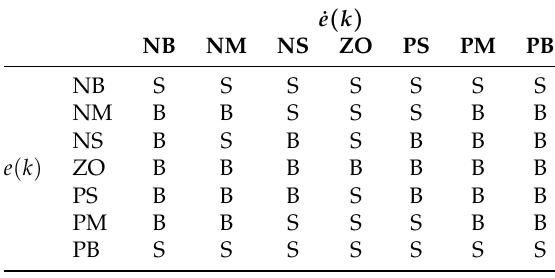
Table 3. Fuzzy rules for Kd (cid:48) [13].